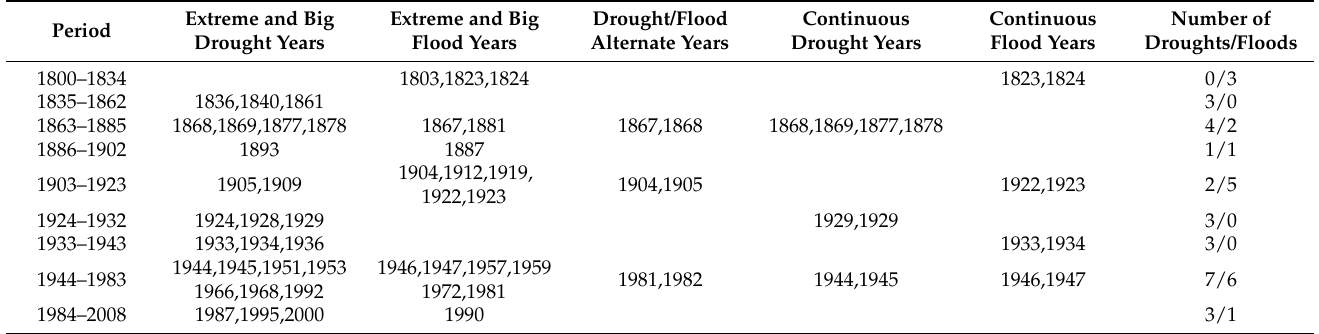
Figure 4. Frequency of droughts and floods in different ages in the upper reaches of the Weihe River Basin in China. Table 2. Extreme and big drought/flood years identified in the upper reaches of the Weihe River Basin in